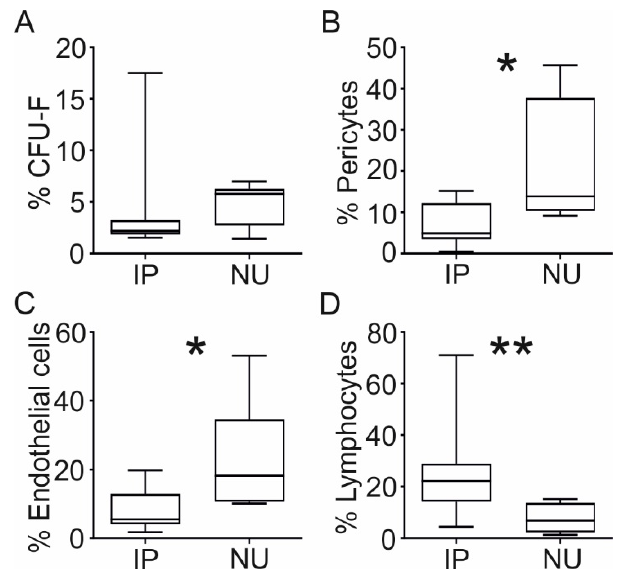
Figure 2. A comparison of cellular composition between NU and induced periosteum (IP) tissue. Comparison of the percentage of colony forming cells assessed by colony forming unit fibroblast (CFU-F) assay following enzymatic digestion and in vitro culture in induced periosteum (IP) ( n = 8) and non-union (NU) tissue ( n = 6) ( A ). Flow cytometry analysis of the percentage of cells expressing cell surface markers consistent with pericytes (CD45 - CD34 - CD146 + ) ( B ), endothelial cells (CD45 - CD31 + ) ( C ), and lymphocytes (CD45 + side scatter low) ( D ), following enzymatic digestion of IP ( n = 10) and NU tissue ( n = 6). * denotes p < 0.05, ** denotes p < 0.01.